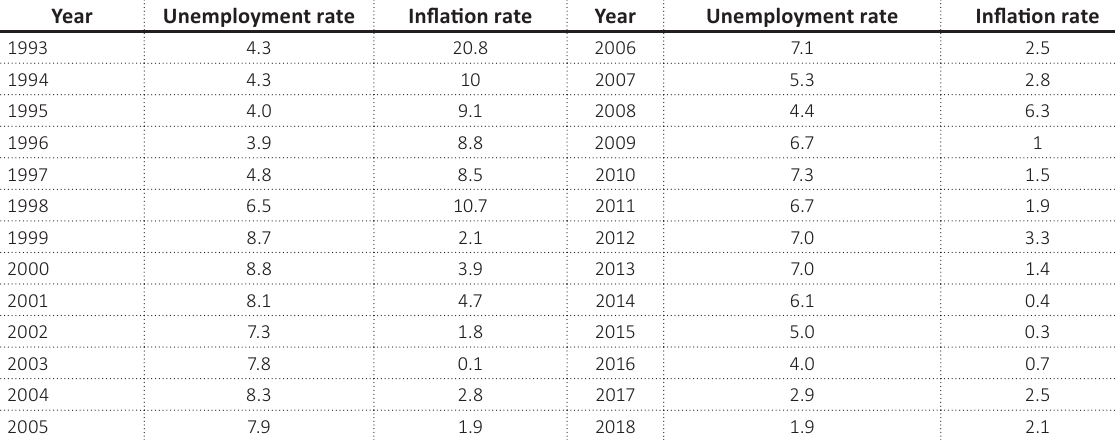
Table 1. Dataset for the unemployment rate and inflation